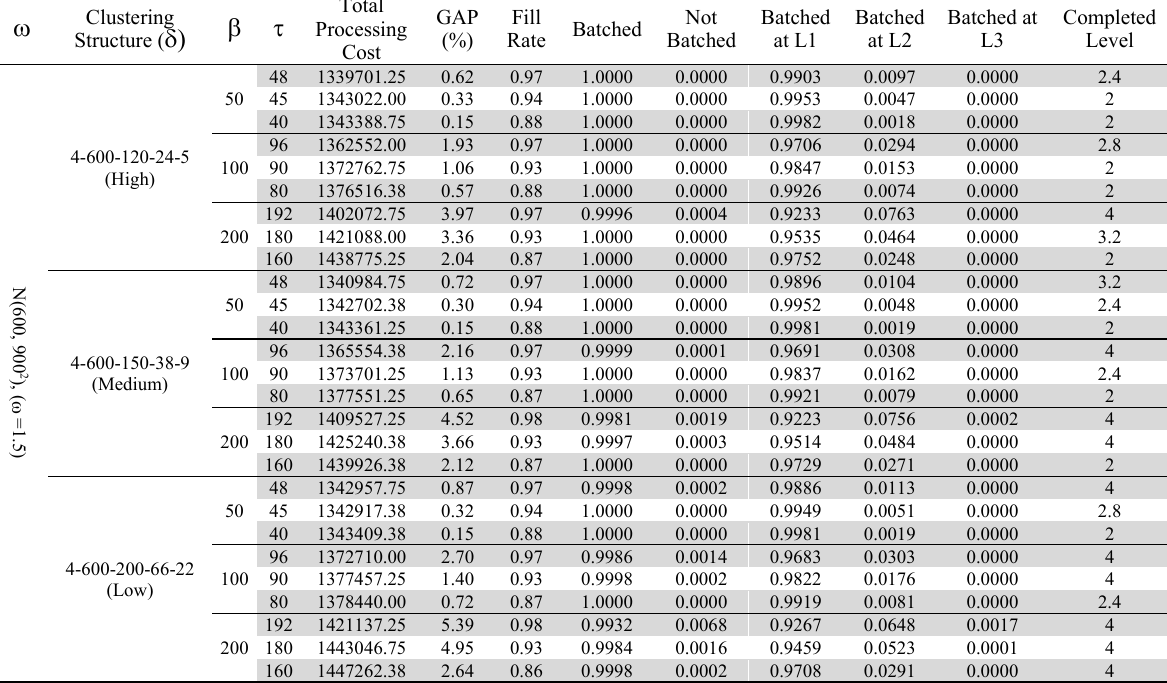
Results for demand scenario S-14 with 4-Level non-exclusive